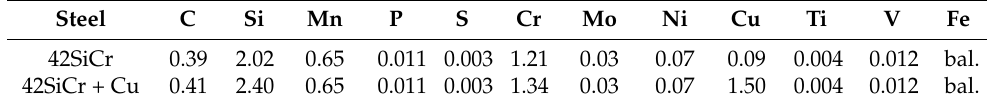
Table 1. Chemical composition of medium carbon steels in the present study (wt%).